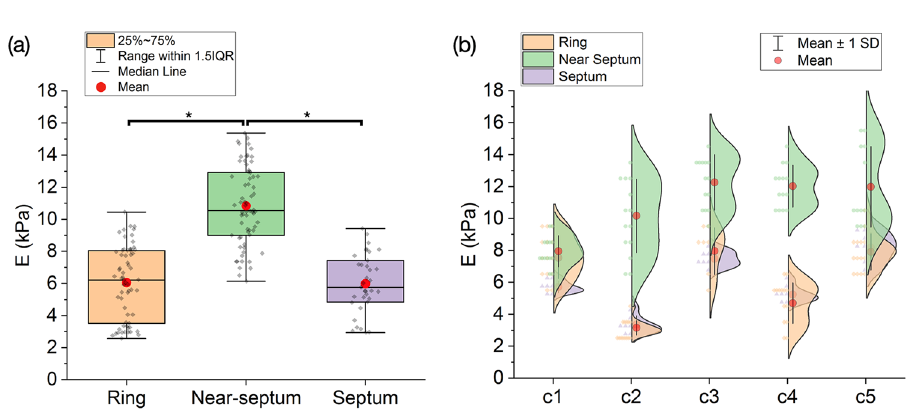
Figure 5. Region-specific indentation modulus of non-pregnant rat cervix. ( a ) Comparison of the indentation modulus in the ring, near-septum and septum. ( b ) Smooth kernel distribution of the indentation modulus in the three regions for five independent cervix samples (c1-c5). Asterisk (*) indicates significant differences ( p <